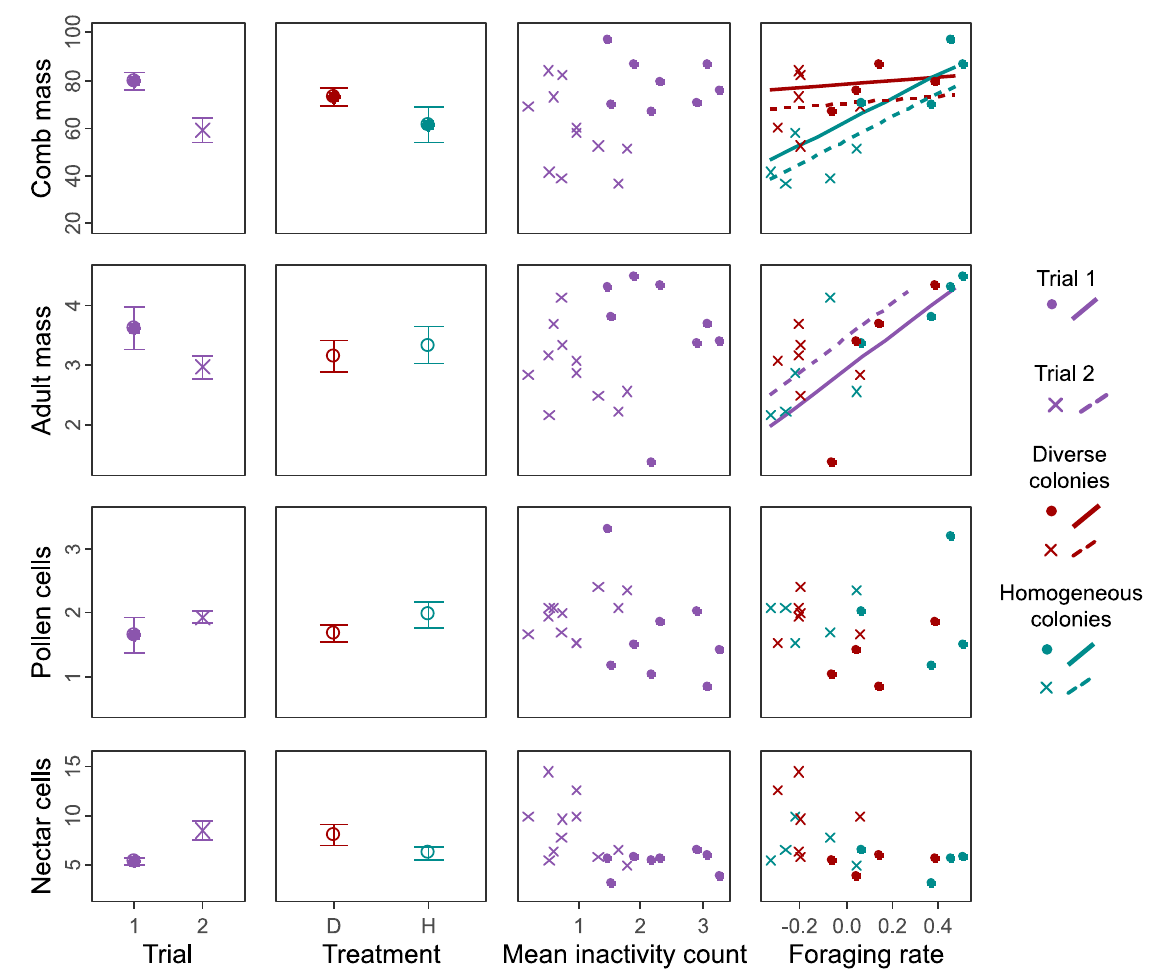
Figure 7. Plot matrix summary of linear models testing the effects of body size distribution and behavioural measures (matrix columns) on indices of colony performance (matrix rows). Circles or crosses represent Trial 1 or 2, respectively. Filled circles (point plots) or slopes (scatter plots) represent terms included in the best model from the model set for each response variable (selected using AICc values). Response variables were: nest comb mass at the end of the experiment (g), total adult mass (arbitrary units calculated by cubing the mean marginal cell length and multiplying it by the total number of adults produced for each colony), mean number of full pollen cells per census, and mean number of full nectar cells per census. For each response variable, the full model included the following predictor terms: Trial , Treatment , Mean worker inactivity count , Colony foraging rate (mean centred), Colony foraging rate × Treatment interaction. Only models with the Trial factor were compared, but otherwise models were selected from all combinations of predictors. For Treatment and Colony foraging rate (where an interaction term with treatment was tested), red/blue points or lines show separate data or fitted interaction slopes for the diverse/homogenous colonies, respectively, otherwise purple points/lines are used. For the fitted slopes, solid lines show the slope for Trial 1, and dashed lines for Trial 2. Point plot error bars show